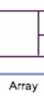
Figure 1. A Photovoltaic Array